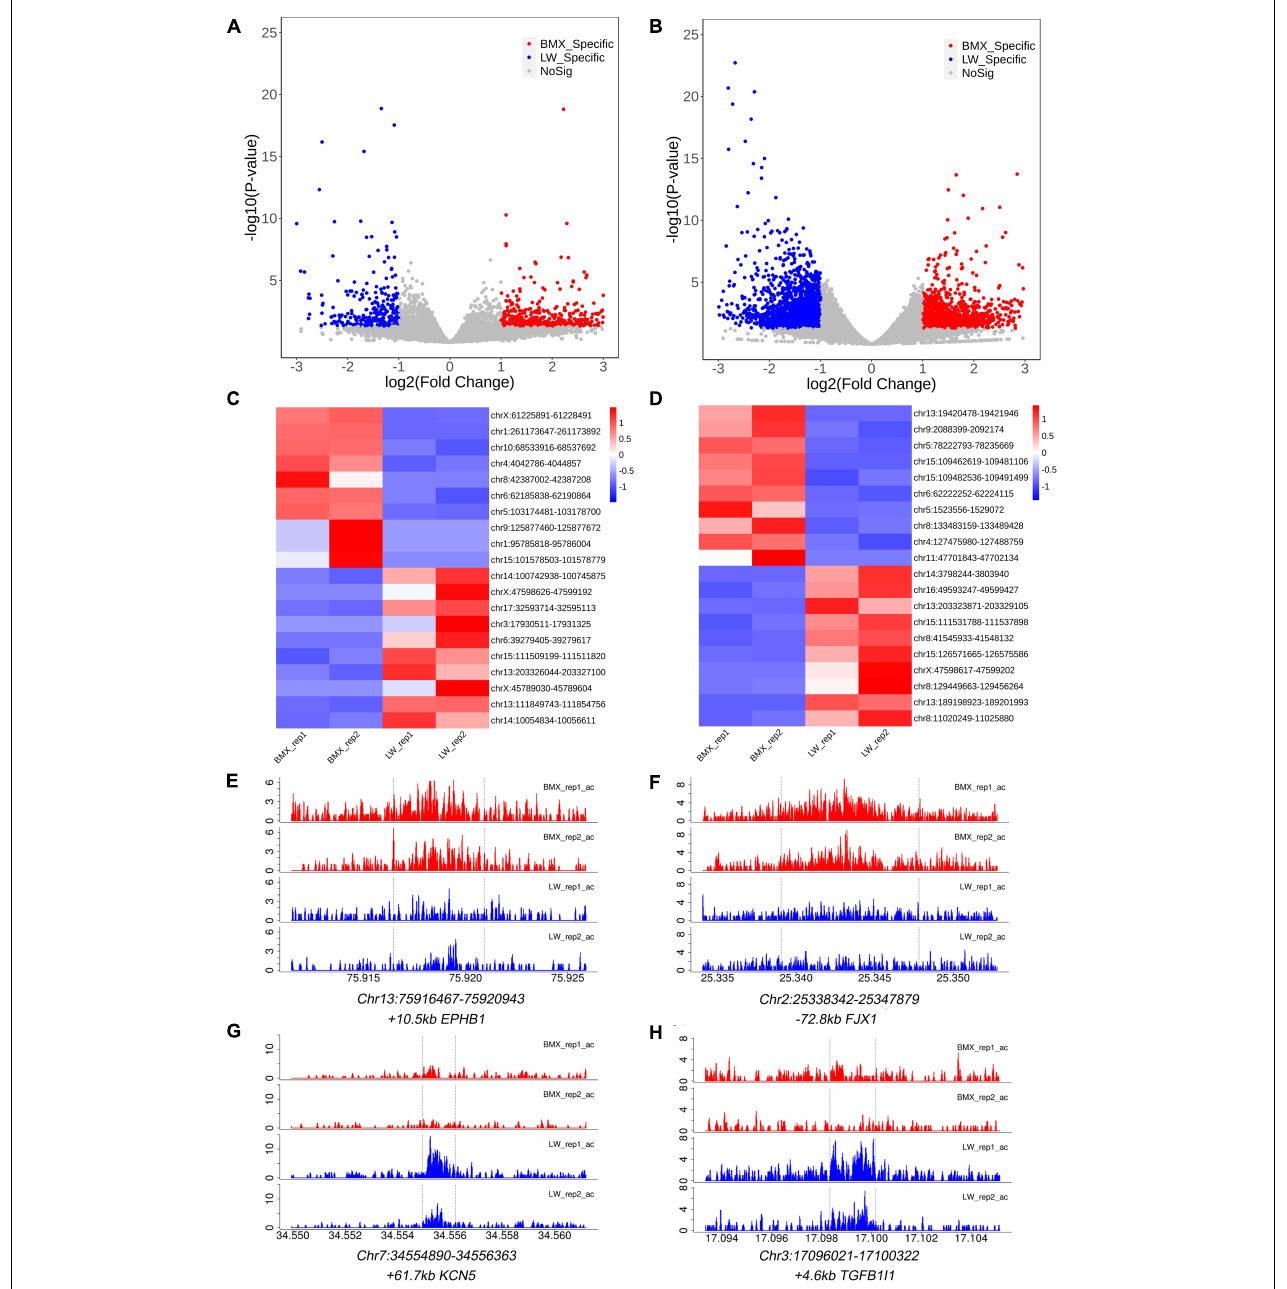
FIGURE 3 | Differential activity analysis on the H3K4me3 and H3K27ac peaks between two breeds and representative validation of differential peaks exhibiting distinct activity of the H3K27ac signal. (A,B) Volcano plot showing the differential activity analysis of H3K4me3 and H3K27ac peaks between BMX and LW breeds. (C,D) Unsupervised hierarchical clustering of the top differential H3K4me3 and H3K27ac peaks between BMX and LW samples. (E,F) The activity track of H3K27ac regions of (Chr13: 75916467–75920943) and (Chr2: 25338342–25347879) with increased hyper-acetylation in the BMX pituitary was related to genes of EPHB1 and FJX1 respectively. (G,H) The activity track of H3K27ac regions of (Chr7: 34554890–34556263) and (Chr3: 17096021–17100322) with higher H3K27ac enrichment in LW was related with KCNK5 and TGFB1I1, respectively.